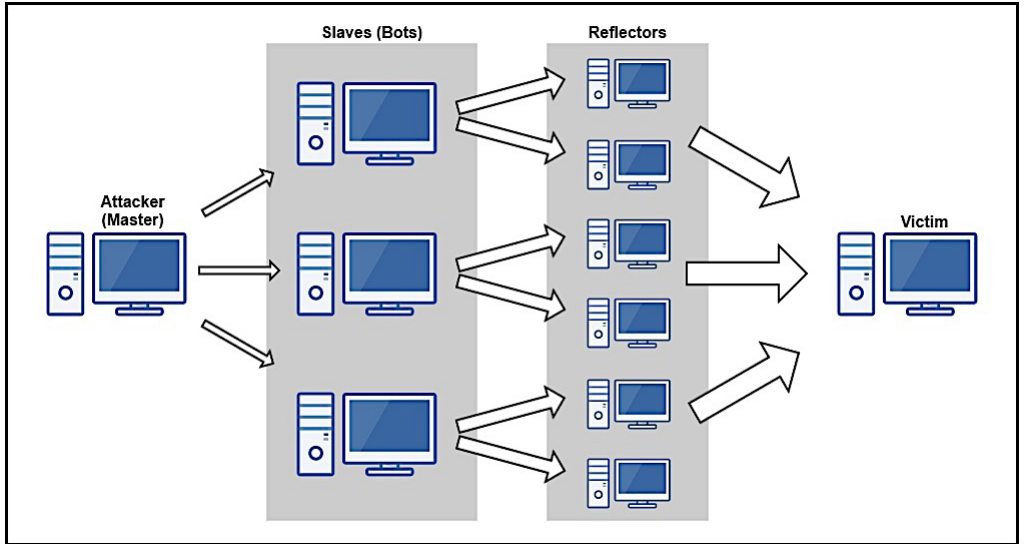
Figure 1. Amplified reflection attack